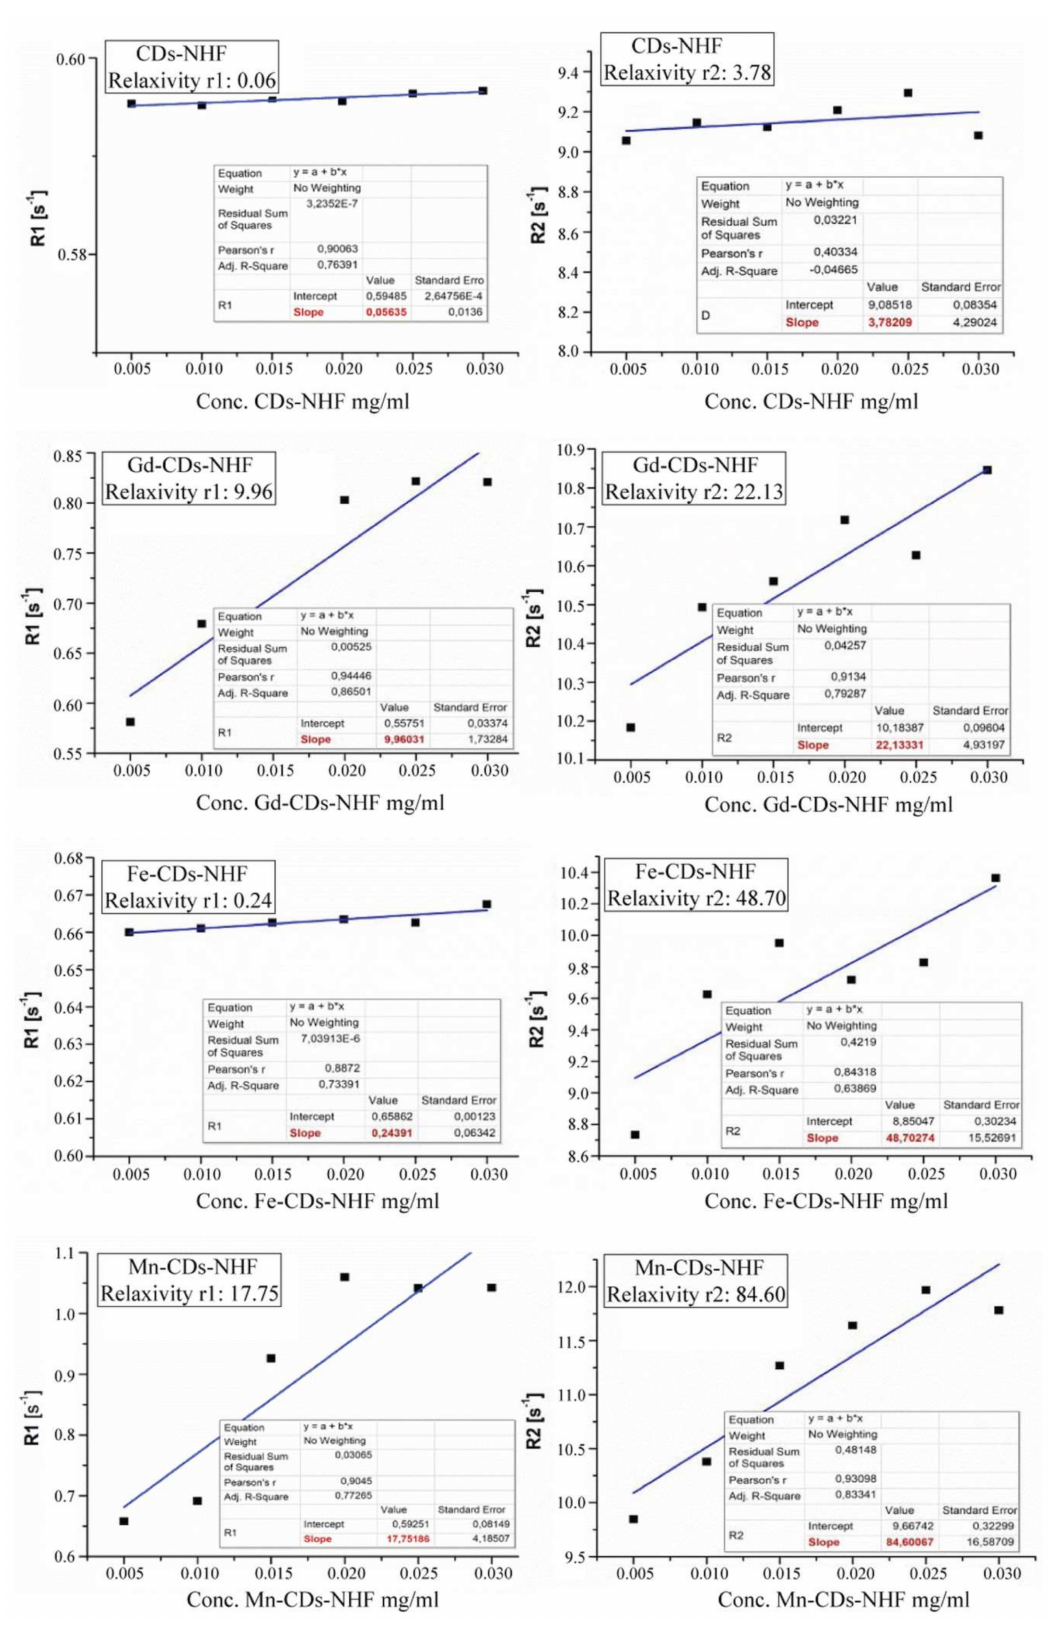
Figure 2. The r1 and r2 relaxivities of CD-NHF (negative control), Gd-CD-NHF (positive control), Fe-CD-NHF, and